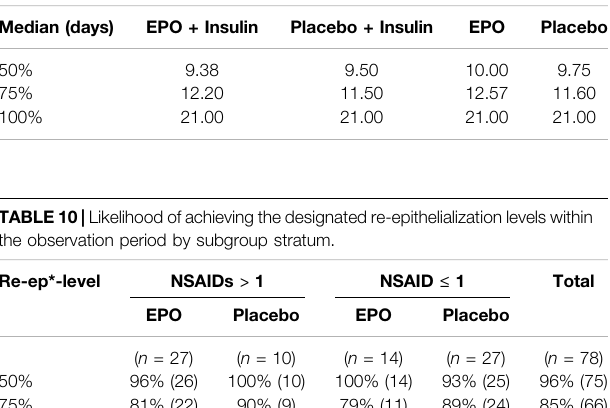
TABLE9| Mediantimerequiredtoreachthedesignatedre-epithelializationlevelin each subgroup stratum in days.